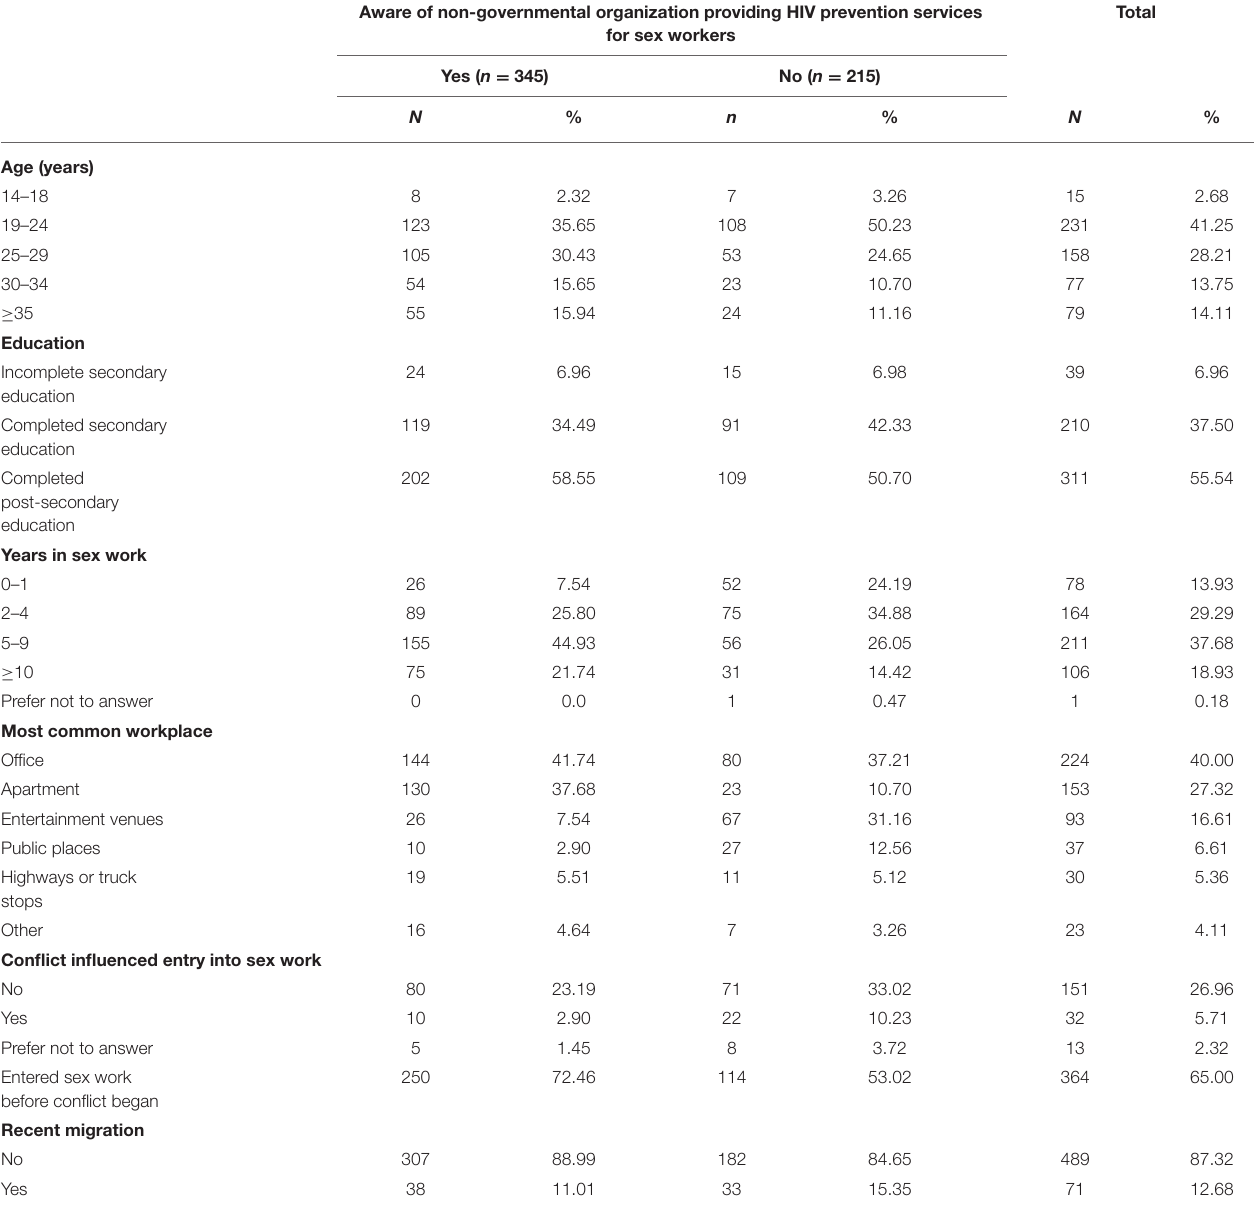
TABLE 1 | Socio-demographic characteristics of sex worker participants, by NGO awareness ( N = 560). Aware of non-governmental organization providing HIV prevention services for sex